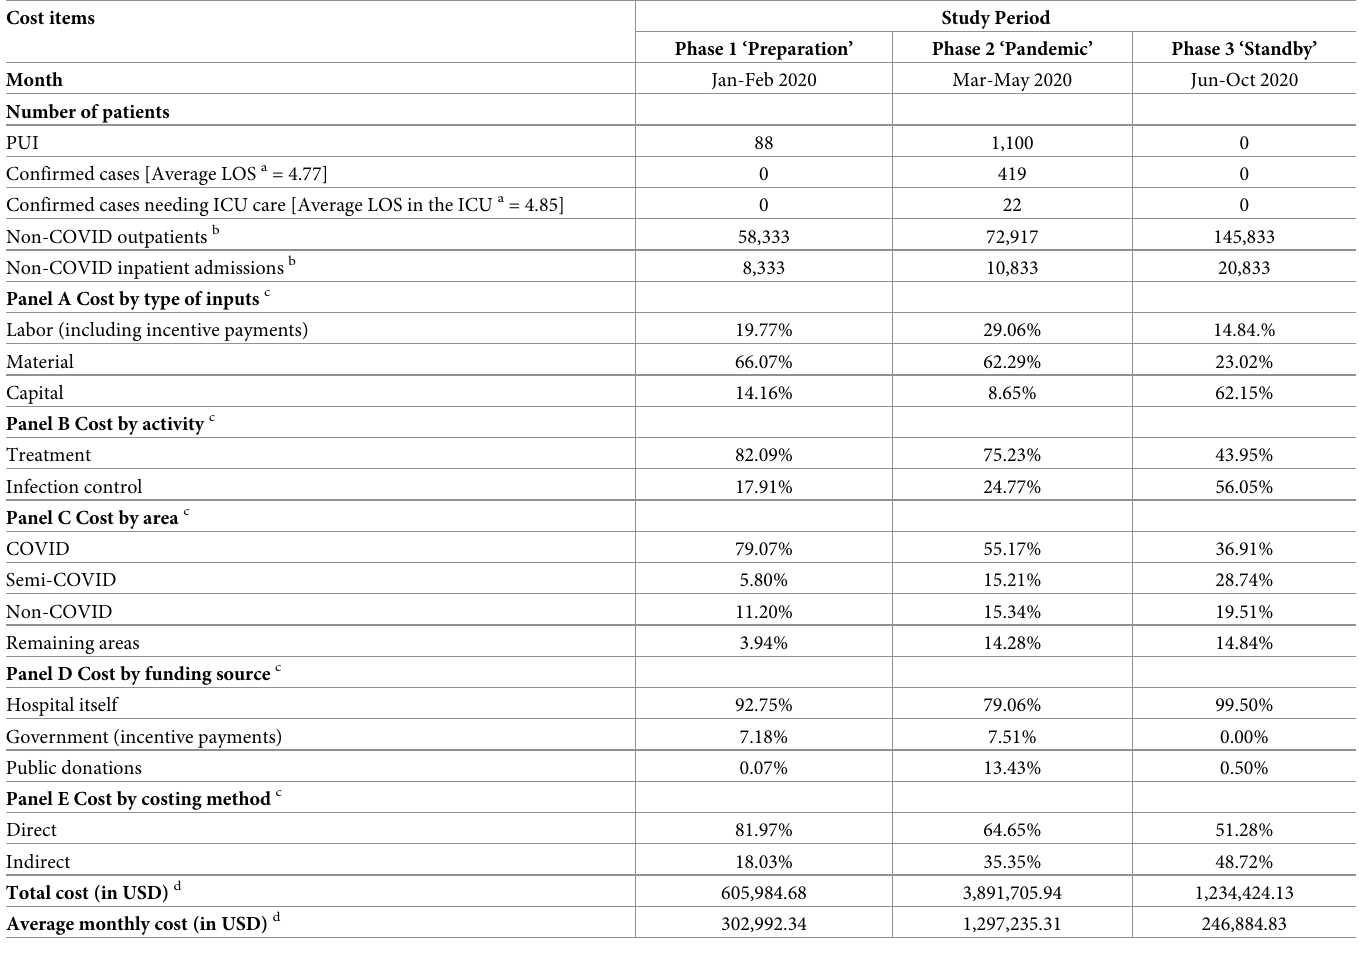
Table 2. Cost items and cost breakdown of the first wave of